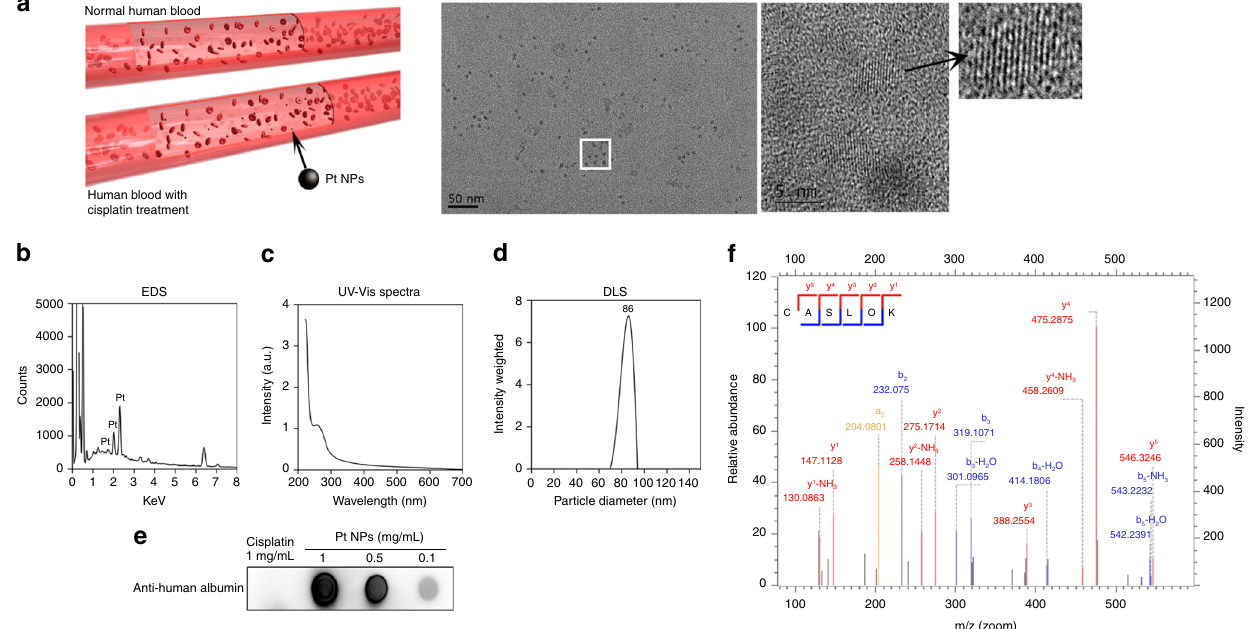
Fig. 1 Characterization of Pt NPs. a Illustration of the biosynthesis of the Pt NPs in human blood. TEM image of Pt NPs and high resolution-TEM image of the lattice fringes. b EDS spectrum of Pt NPs isolated from patient blood. c UV − vis absorption spectrum of HPLC-puri fi ed Pt NPs from patient blood. d The size distribution of Pt NPs in phosphate buffer was characterized by DLS. e Dot blot assay to detect human serum albumin in Pt NPs. Cisplatin was used as the control. f Identi fi cation of albumin in Pt NPs by MS. The MS spectra and the resulting peaks were searched against the Swiss-Prot protein sequence